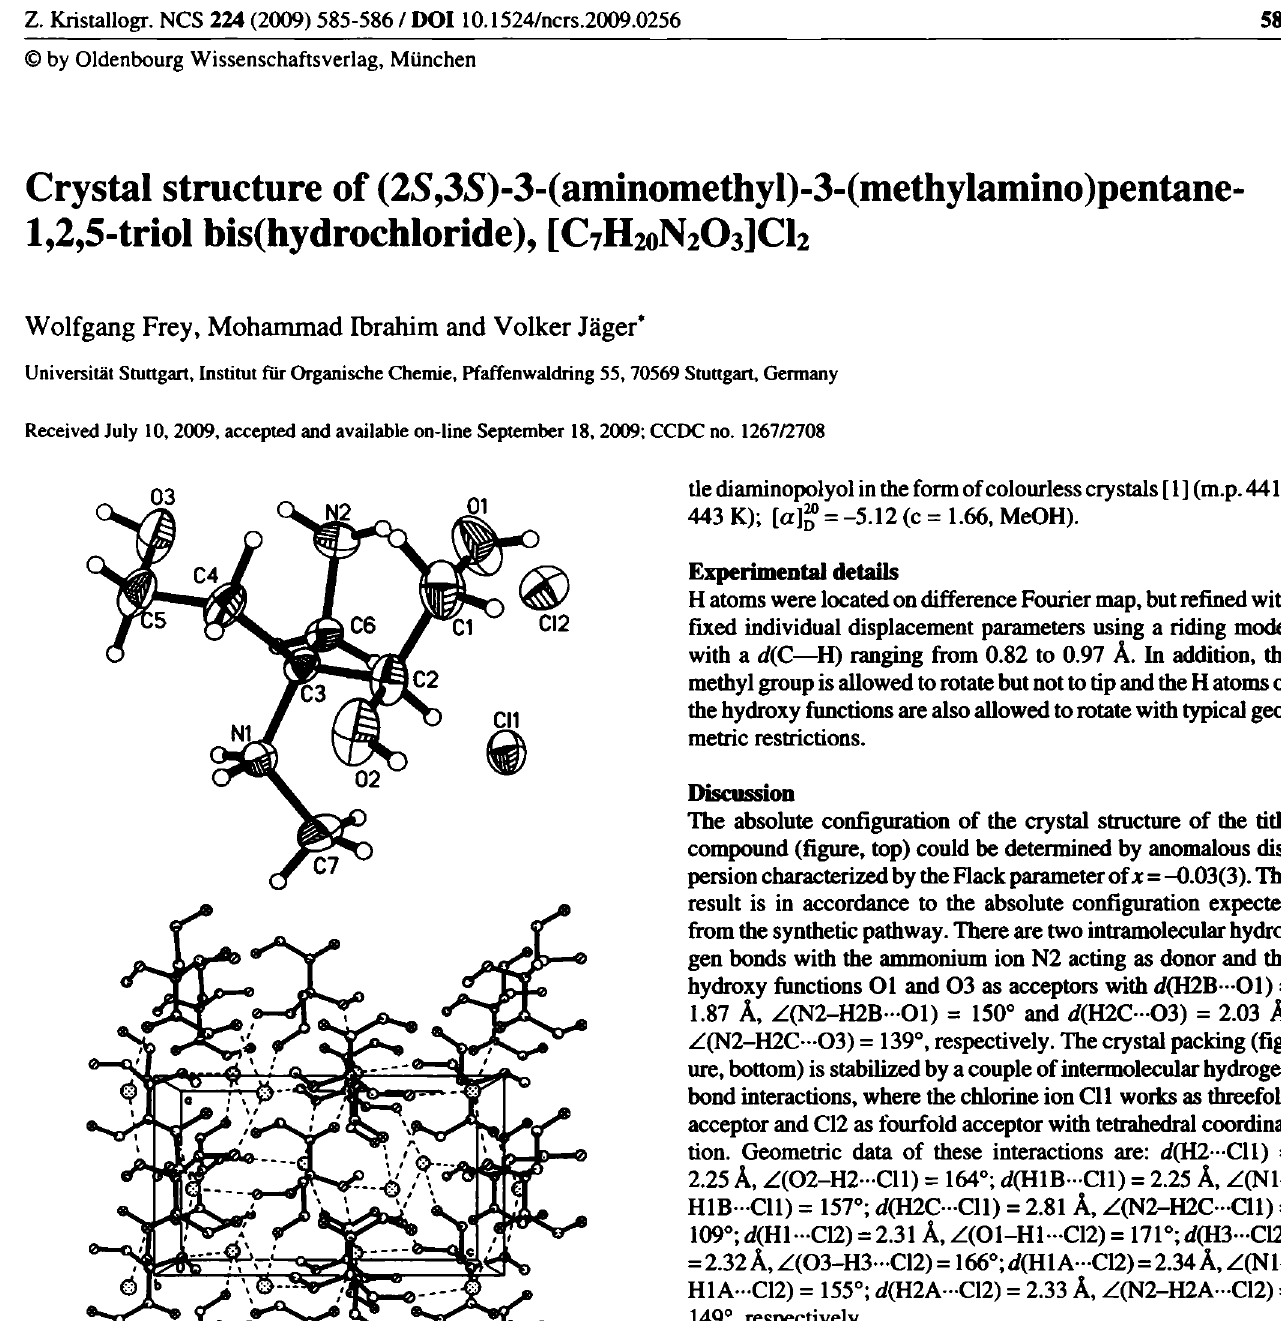
Table 1. Data collection and